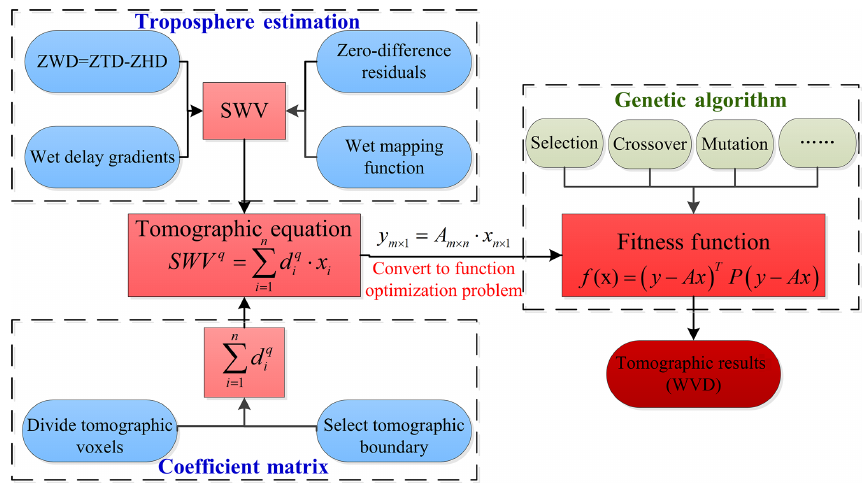
Figure 1. Flowchart of the water vapour tomography based on the genetic algorithm.